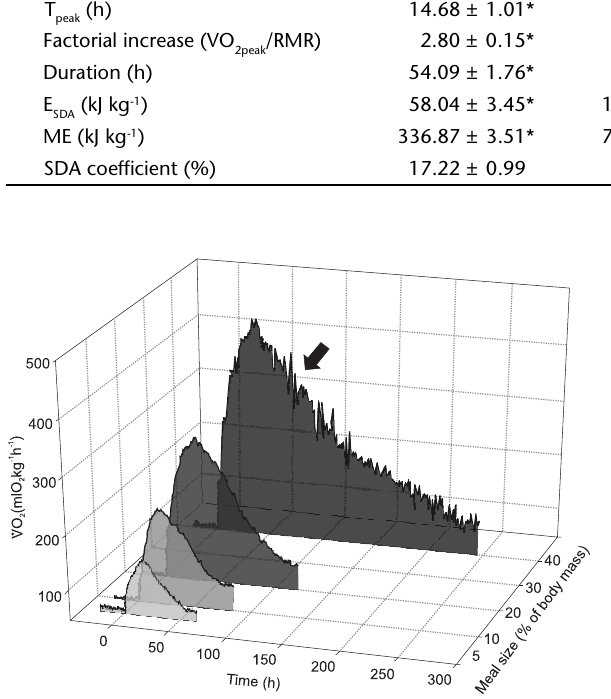
Figure 1. Time course variation in mean oxygen consumption rates ) during the digestion of Bothrops alternatus fed on meals with (VO 2 different relative sizes at 30°C. Time zero indicates the moment of meal ingestion. The arrow in G40% indicates the averaged time in which all but one snakes in this group regurgitated their prey. N = 6 in all cases, except for G40% after the arrow, n = 1. SE not shown for clarity.